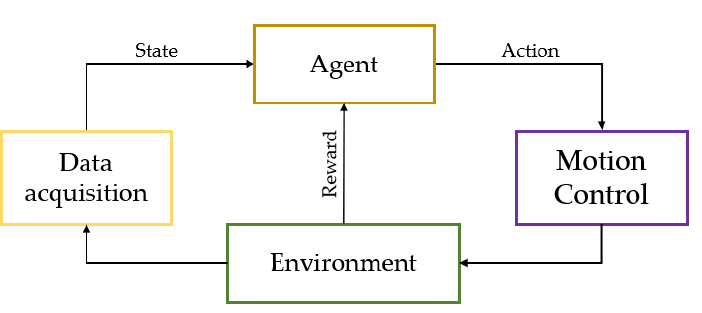
Figure 4. Agent environment interaction